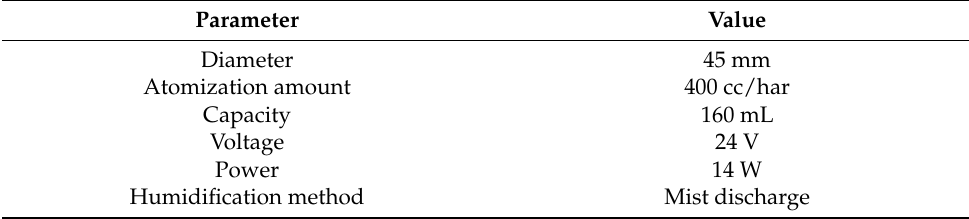
Table 1. Specifications for the ultrasonic humidifier.